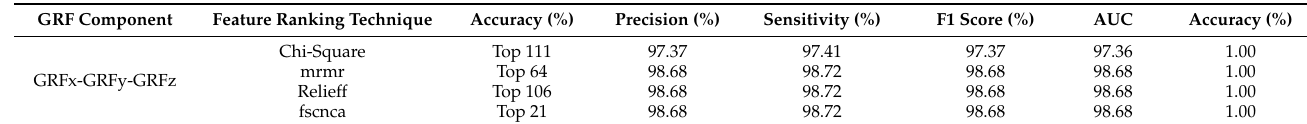
Table 9. Evaluation matrix for three-channel analysis for GRF data using different feature selection techniques.